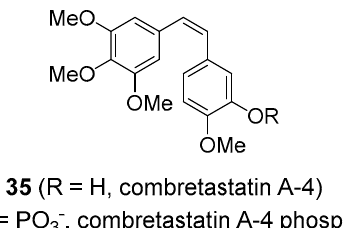
Figure 9. Molecular structures of combretastatins.